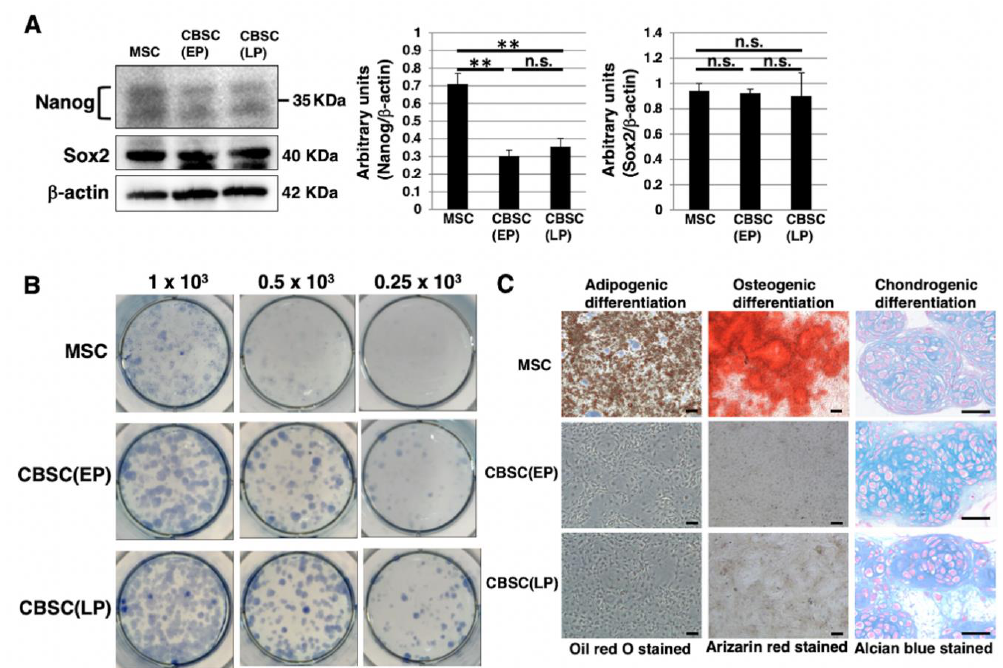
Figure 2. Stemness features of mCBSCs. ( A ) Western blot analysis of Nanog, Sox2, and β -actin (loading control) in mMSCs and mCBSCs (EP and LP). The blot images were cropped to highlight the Nanog, Sox2, and β -actin bands. The histogram shows the mean densitometric analysis ± SD of Nanog or Sox2 normalized to the loading control ( β -actin). The values were obtained from three independent experiments. ** p < 0.01, n.s.: not significant. ( B ) Colony-forming assay in mMSCs and mCBSCs (EP and LP). Cells were plated at low density (0.25 × 10 3 cells, 0.5 × 10 3 cells, or 1 × 10 3 cells/well) and cultured. After 7 days, cells were stained and photos were captured. Two independent experiments were performed and representative images are shown. ( C ) Adipogenic, osteogenic, or chondrogenic differentiation was induced in mMSCs and mCBSCs (EP and LP). Two independent experiments were performed and representative images are shown. Scale bar in the phase contrast image of adipogenic and osteogenic: 2 µ m. Scale bar in the phase contrast image of chondrogenic: 50 µ m. Abbreviations: mMSC, mouse mesenchymal stem cell; mCBSC, mouse cortical-bone-derived stem cell; EP, early passage;